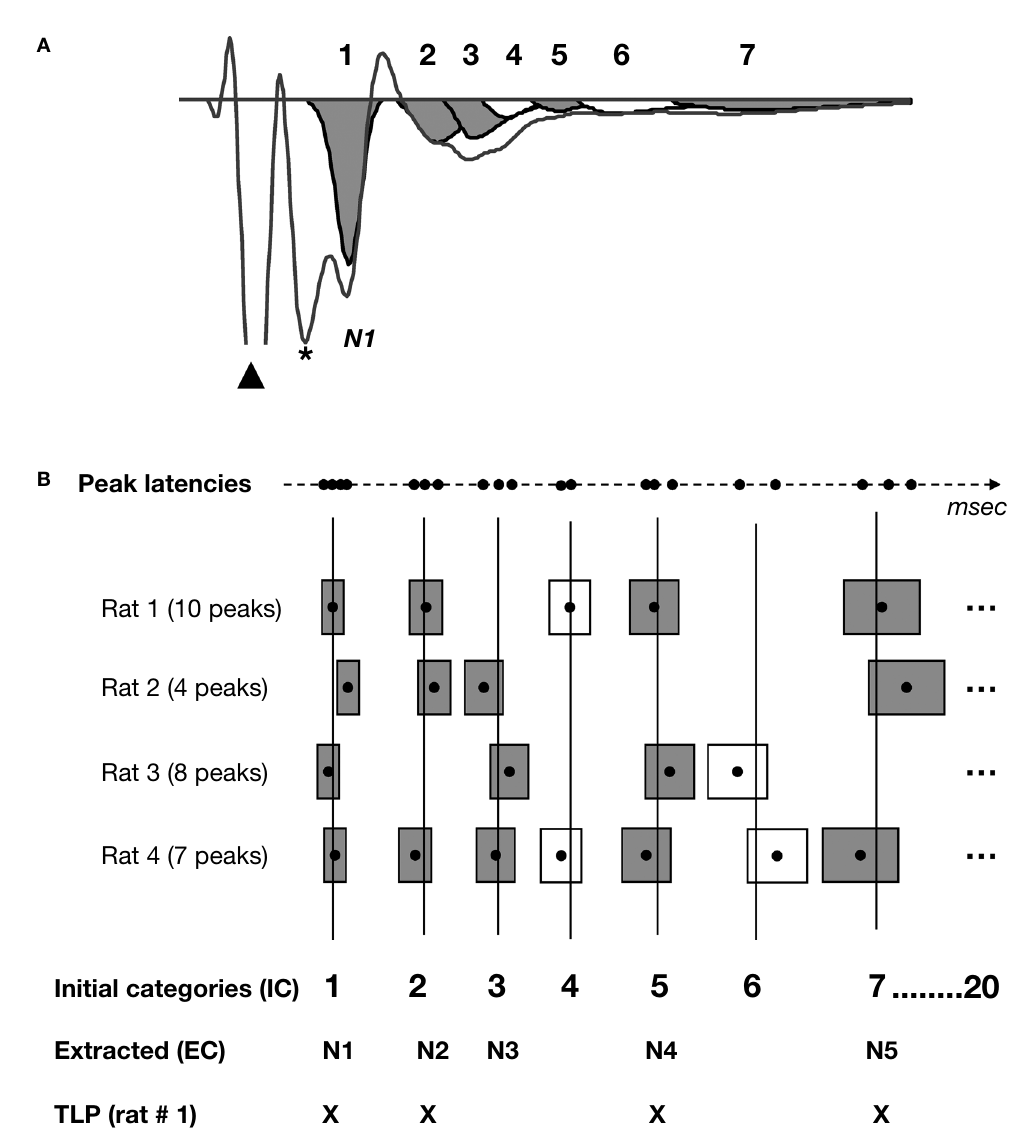
Figure 3 | Schematic of the method used for the extraction of time-locked peaks (TLPs). The detailed methodology is described in the Materials and Methods section of the manuscript. (A) Example of an averaged FP recorded in vitro , and seven peaks fi tted using PeakFit software, when excluding the stimulus artifact (black triangle) and fi ber volley ( * ). For this particular case, following the procedure depicted in (B) , fi ve peaks were found to be reliable for this condition (in grey), while two peaks were not (in white). (B) Procedure for the extraction of TLPs. For clarity, the examples here depict hypothetical cases for which peak latencies are very well clustered among animals. For each animal and each peak latency (black dot), as fi tted in (A) , a “zone of variability” (box) was calculated around the peak latency. Then, the peaks across all animals in the same condition (e.g., in vitro LAd-s) were identifi ed, and using their zones of variability, unique initial categories (IC, vertical lines) were defi ned. For example, in the case of in vitro LAd-s, 20 initial categories were formed. Of these, fi ve were identifi ed as reliably present across all animals and labelled “extracted categories” (EC, numbered in an ascending manner N1 to N5, corresponding to the centers of the gray boxes). For each animal, the peaks that coincided with the ECs are referred to as its time-locked peaks (TLPs). For instance, Rat 1 has only four TLPs, whereas Rat 4 has fi ve [like in the example shown in (A)